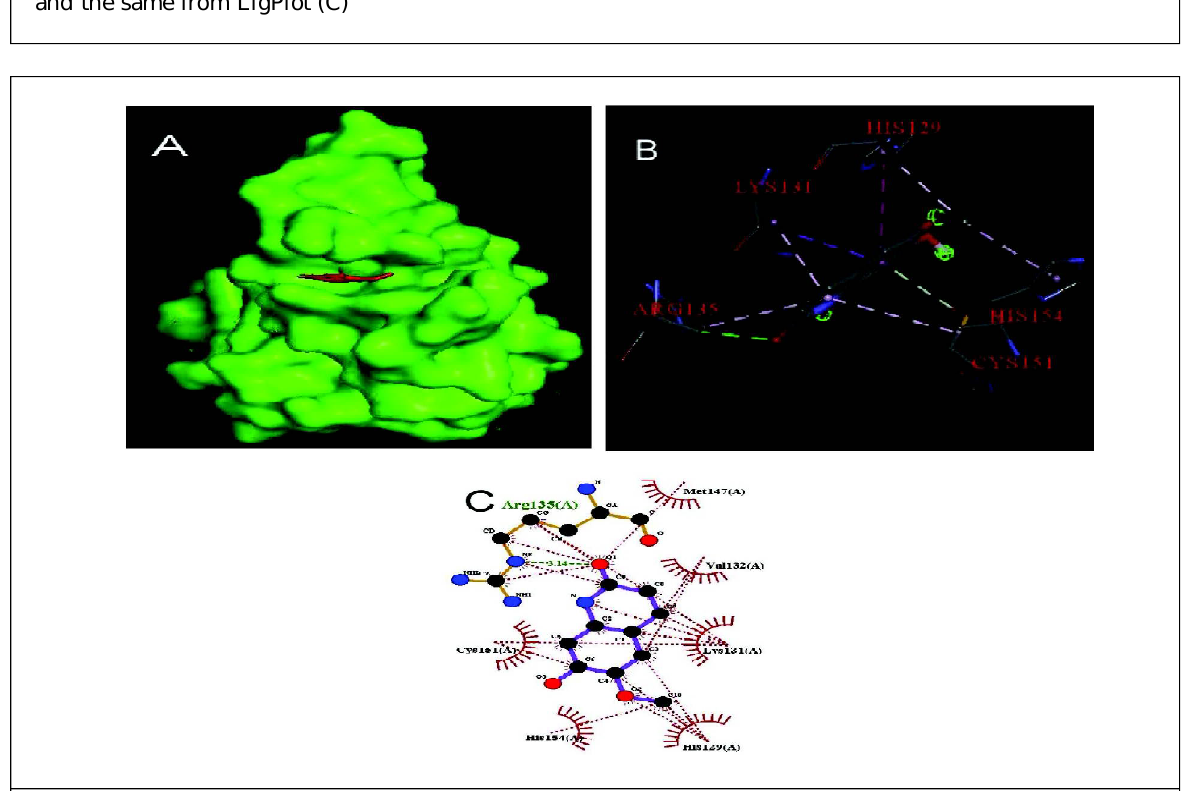
Figure 8: The pictorial illustrations for the Scopoletin-1 derivative in the BTB domain (PDB: 5DAD), including the surface view of the top-ranked docked pose (A), interaction analysis from Accelrys Discovery Studio (B) and the same from LigPlot